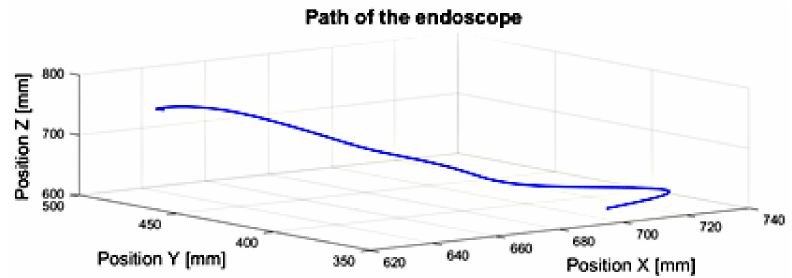
Figure 16. The path of the endoscopic tool during the positioning movement after passing through a trocar simulated with a spherical joint in relation to the heart tissue. The tool has four degrees of freedom.